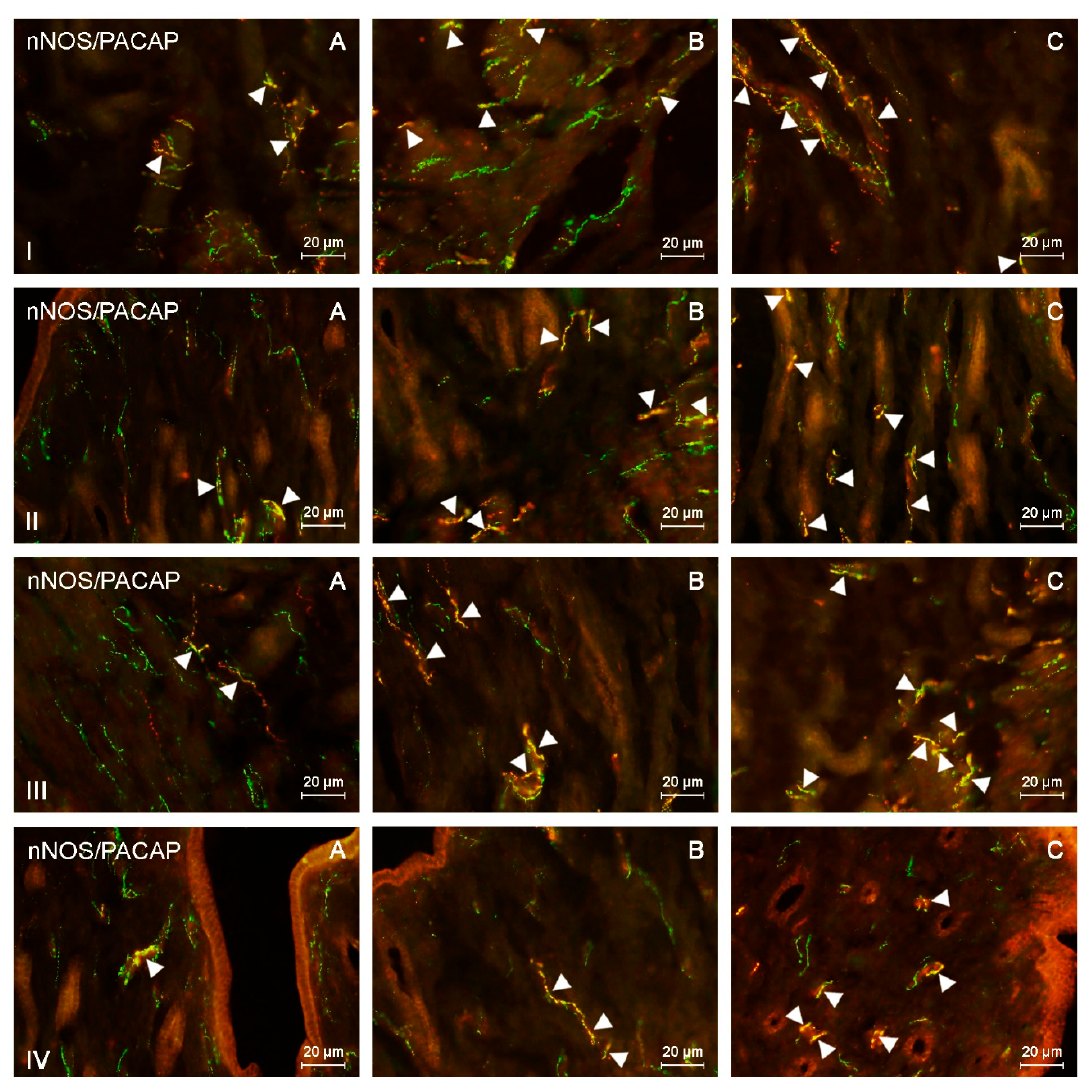
Figure 1. Neuronal nitric oxide synthase (nNOS)-positive nerves (nNOS + green) immunoreactive to pituitary adenylate cyclase-activating peptide (PACAP) (red) in the: (I) muscular layer of the corpus, (II) mucosal layer of the corpus, (III) muscular layer of the horns, (IV) mucosal layer of the horns of the uterine body of control animals ( A ) and pigs treated with low ( B ) and high ( C ) dose of bisphenol A. Nerves simultaneously immunoreactive to nNOS and PACAP (yellow) are indicated with arrowheads.